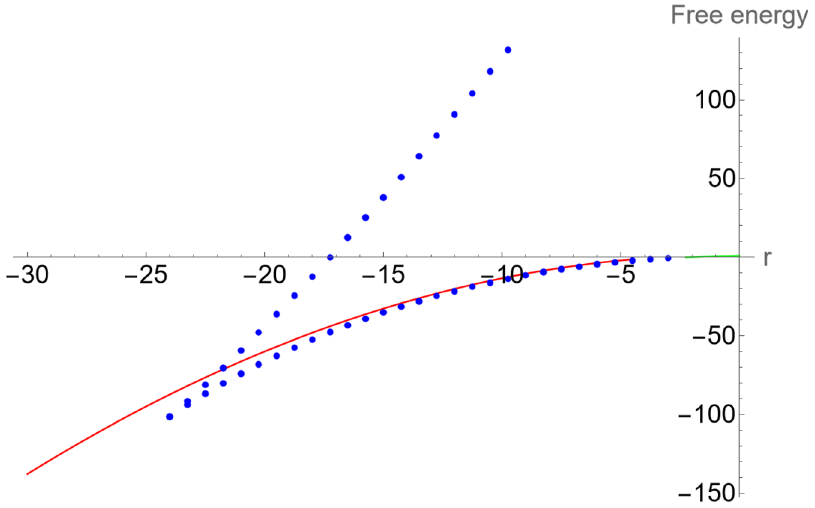
Figure 4 . Free energies of the three phases for a fixed value g = 0 . 4 . The color code is the same as in the previous figure: green line is the symmetric one-cut free energy, red line is the asymmetric one-cut free energy and the blue dots are free energies of the two different types of two-cut solution. As we can see, for certain value of r the regime shifts from the two-cut phase to the asymmetric one-cut phase with a discontinuous jump in the free energy. Note that there are two different two- cut solutions for given values of parameters, only the solution with lower free energy is relevant for our